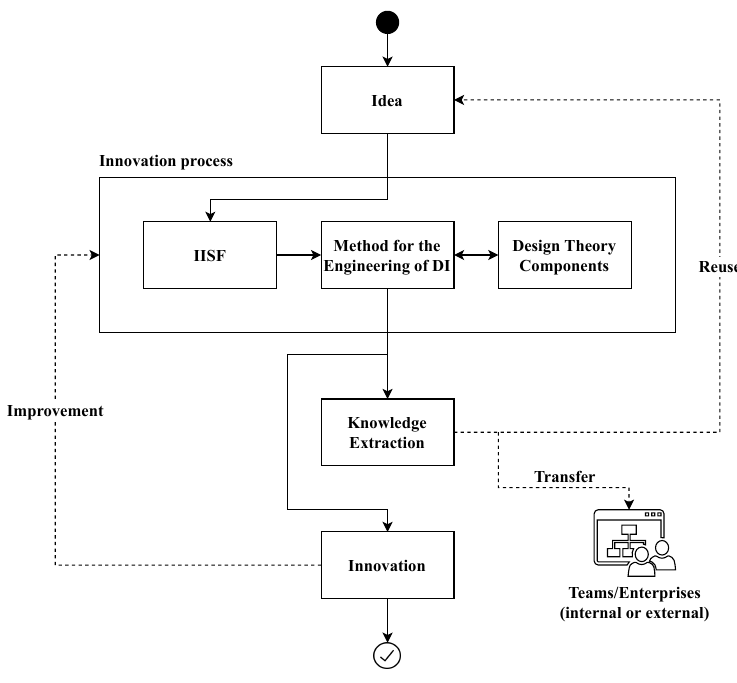
Figure 1. Solution overview: proposed aggregation of DSR artifacts for